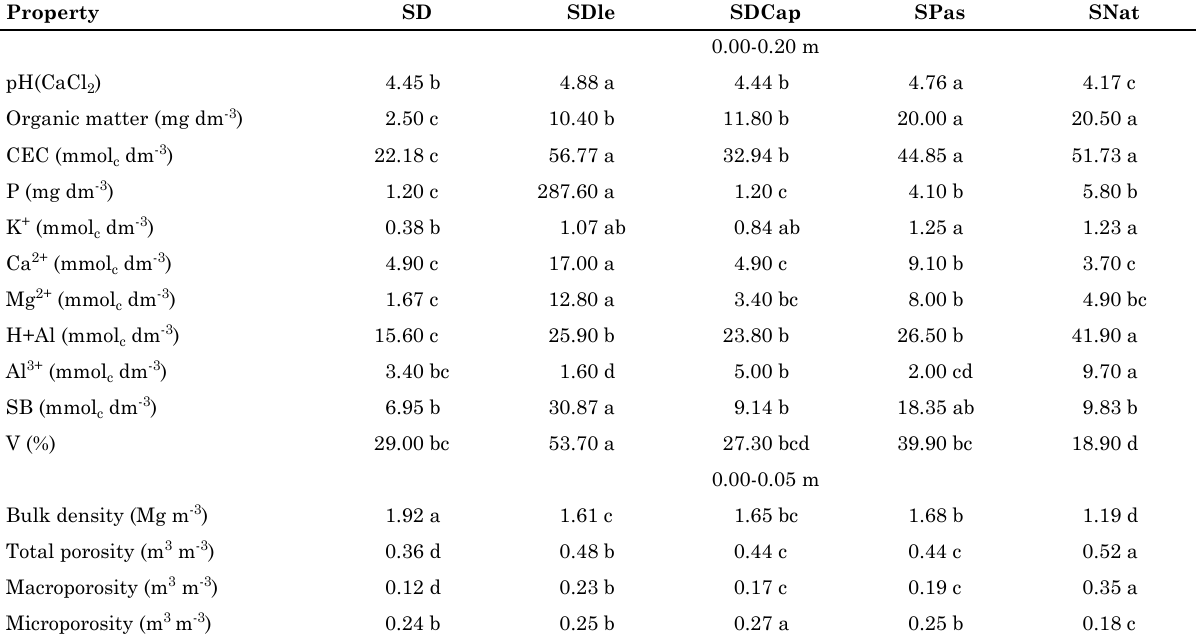
table 3. soil chemical and physical properties around the ilha solteira hydroelectric Plant, sP, brazil. Determinations were performed in 2004 for soils corresponding to different levels of anthropogenic